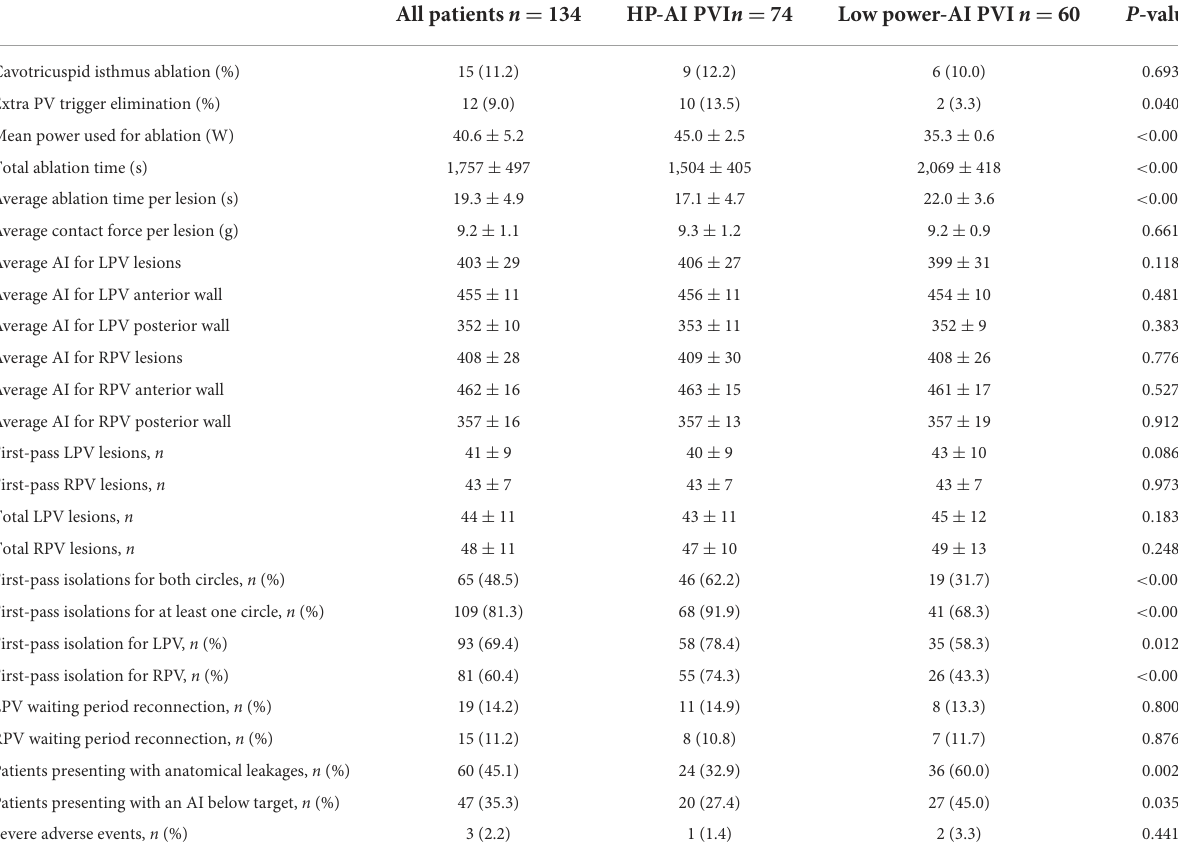
TABLE 2 Procedure data between the HP-AI group and the low power-AI group. All patients n = 134 HP-AI PVI n = 74 Low power-AI PVI n =